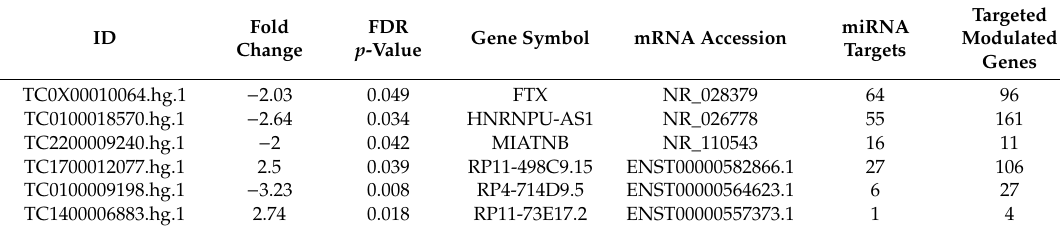
Table 4. Selected lncRNAs modulated in RA patients.